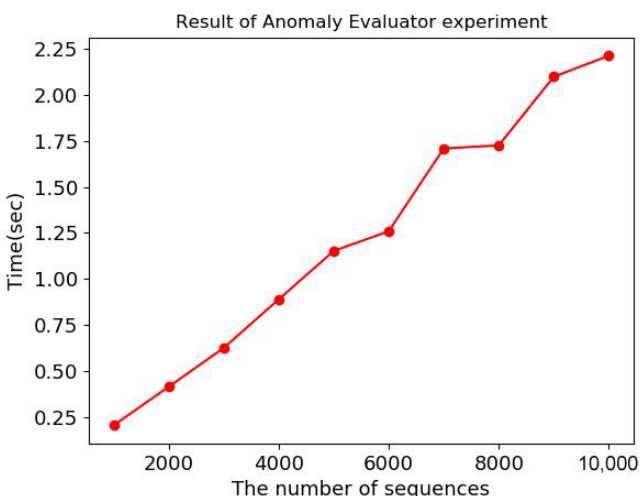
Figure 16. Result of Anomaly Evaluator experiment.